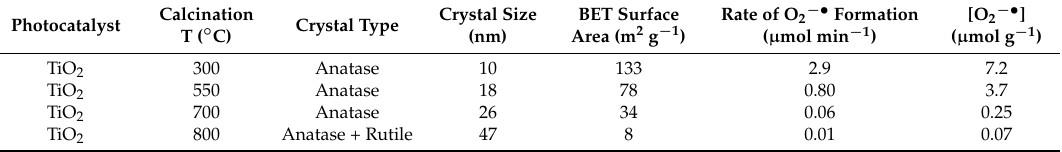
Table 2. Crystal size and surface area of the titania photocatalysts together with the rate of formation and the quantities of the O 2 −• radical anions **.